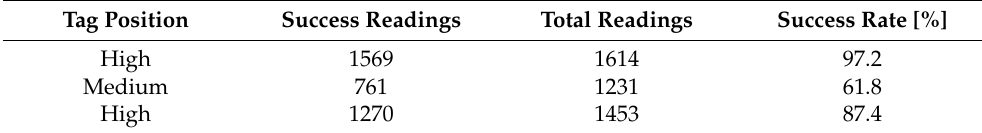
Table 10. Summary of results from Test 6 in terms of success reading rate.